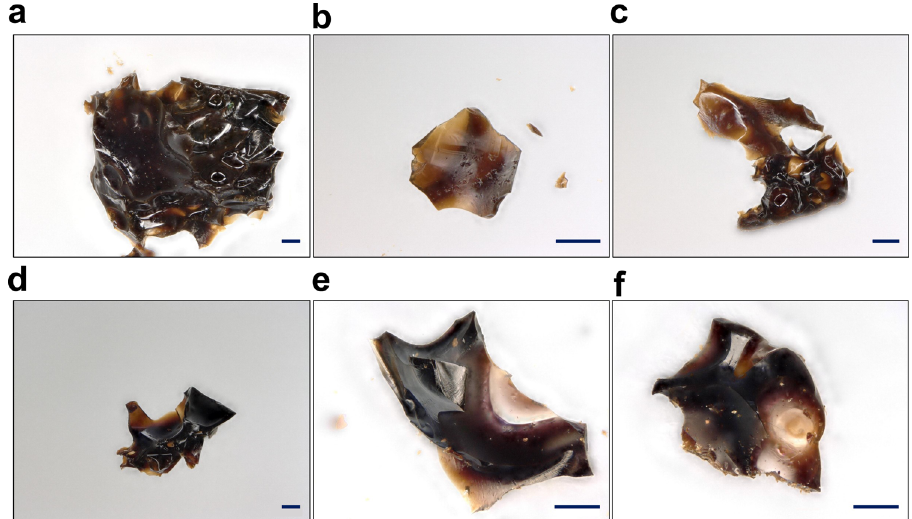
Fig. 3 Confocal microscopy images showing evidence of melting and glass formation. a – c a g (IL@ZIF-8-LT). d – f a g (IL@ZIF-8-HT). Scale bars are 100 µ